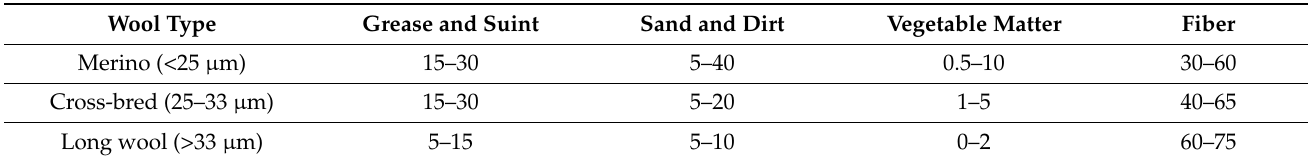
Table 8. Composition in % of greasy wool. The micron limits for the three wool types are only informative